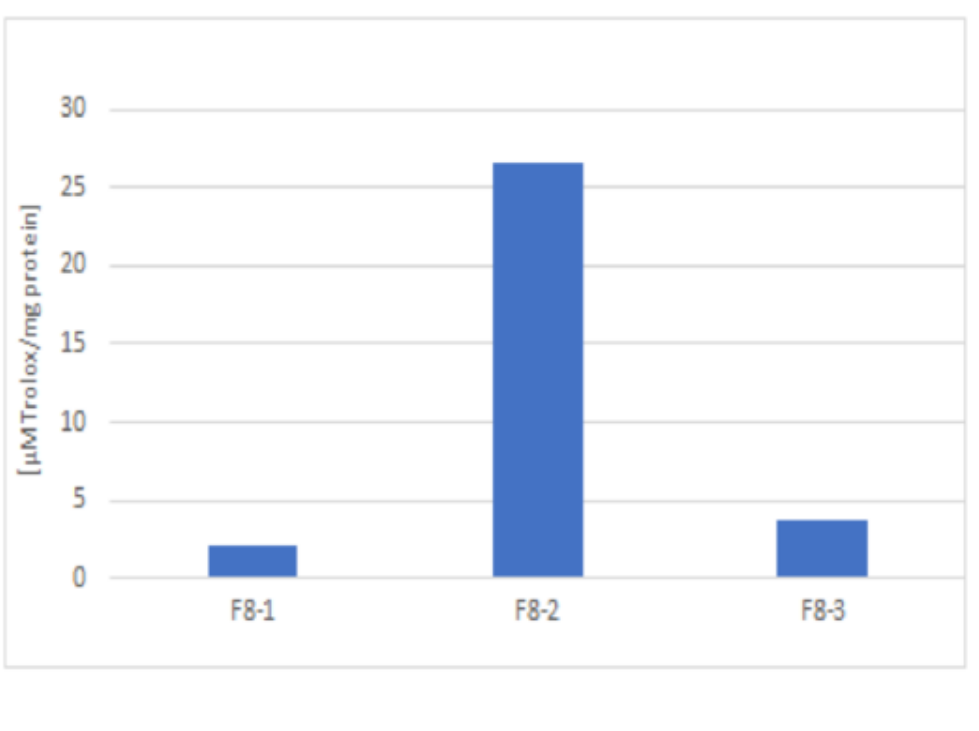
Figure 2. ( A ) The reversed-phase HPLC pattern of the F8 fraction obtained by gel filtration and ( B ) the FRAP activity of the eluted peaks expressed in µ M Trolox/mg protein.